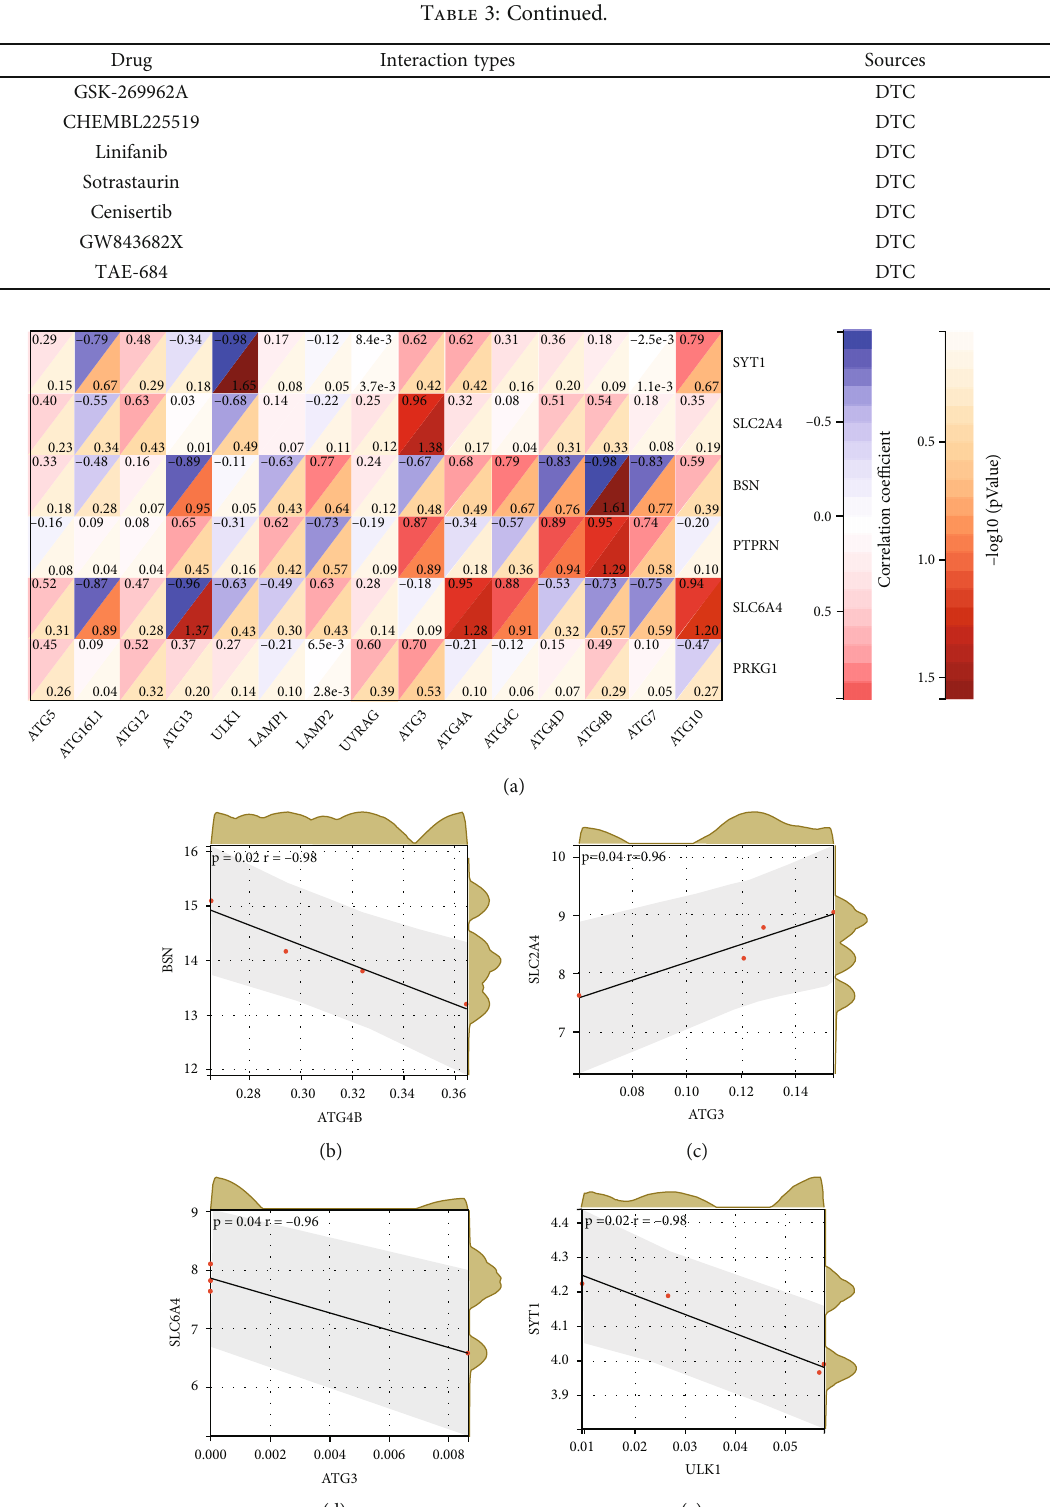
Figure 6: Correlation between hub genes and autophagy genes. (a) Landscape of the correlation between hub genes and autophagy genes. (b) The correlation between BSN and ATG4B. (c) The correlation between SLC2A4 and ATG3. (d) The correlation between SLC6A4 and ATG13. (e) The correlation between SYT1 and